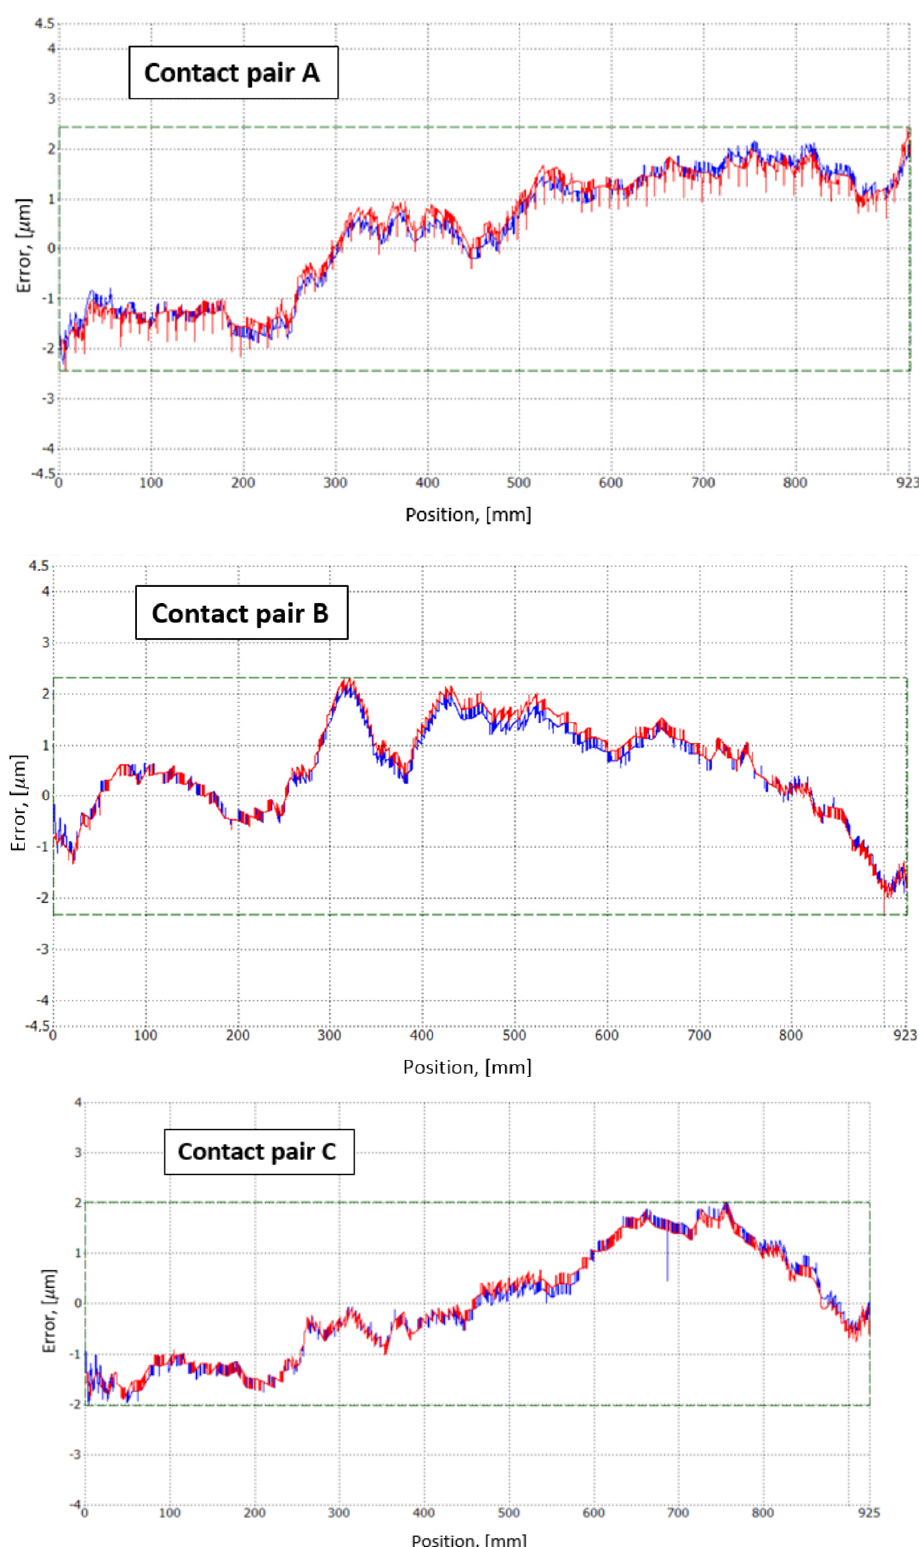
Figure 11. Error of the linear encoder with different mechanical constructions of the experi- mental reading head. (The graphs show the results of different contact pairs ( A – C ). Red and blue lines describe the position measurement errors when the reading head moves forward and backward,